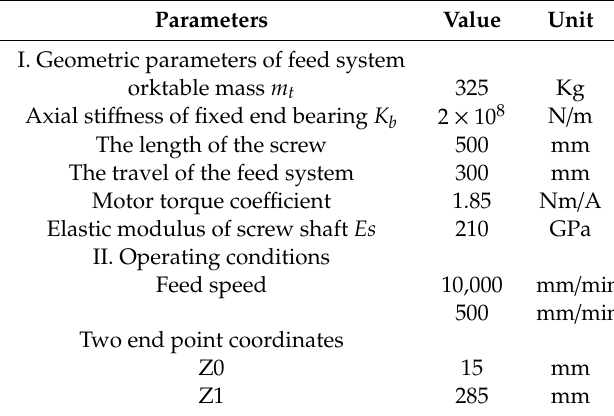
Figure 25. Experimental system. Table 2. Specific parameters of experimental CNC